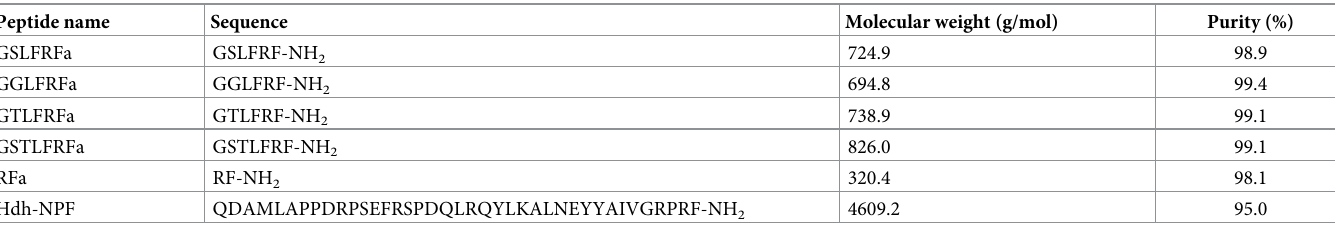
Table 2. Amino acid sequences of